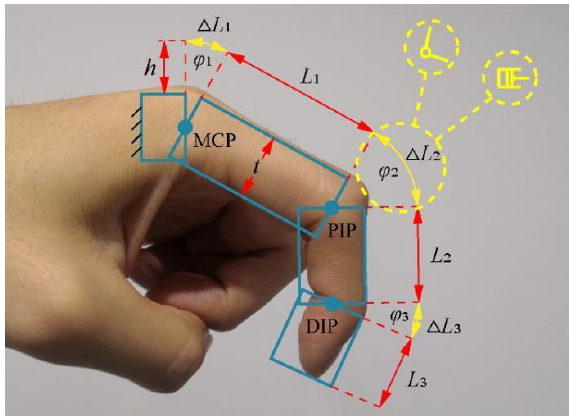
Figure 1. Basic design principle of hand exoskeleton.